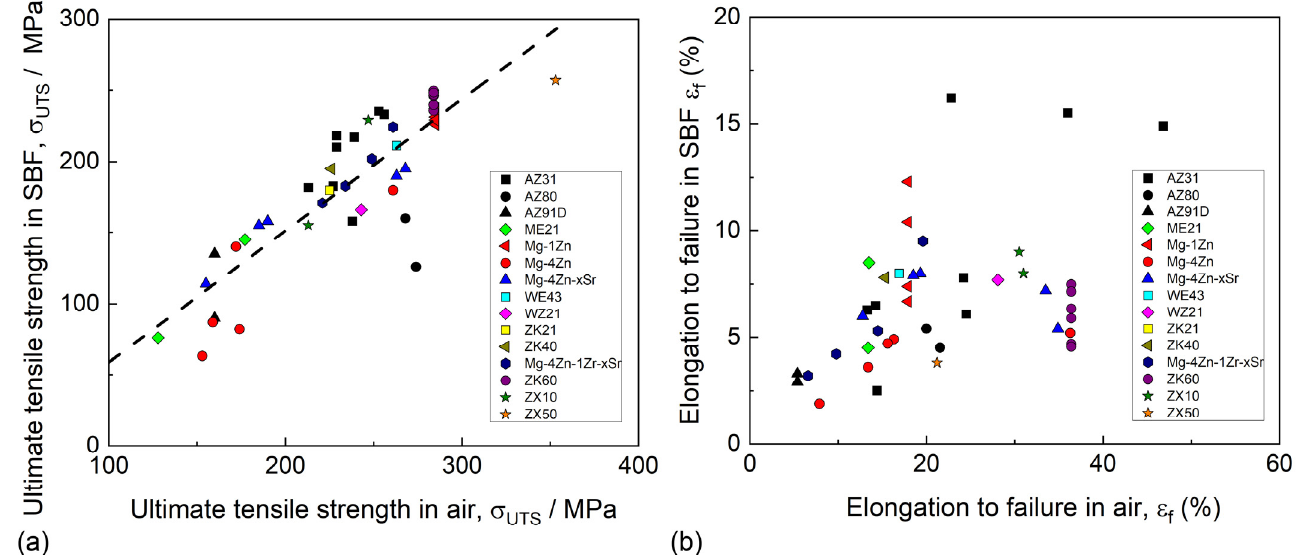
Figure 9. The relationships between the strength level of the biodegradable Mg alloys and their SCC susceptibility indexes by ductility (I EFSCC ) ( a ) and strength (I UTSSCC ) ( b ) in SBFs; data are imported from Table 5 and the references therein.